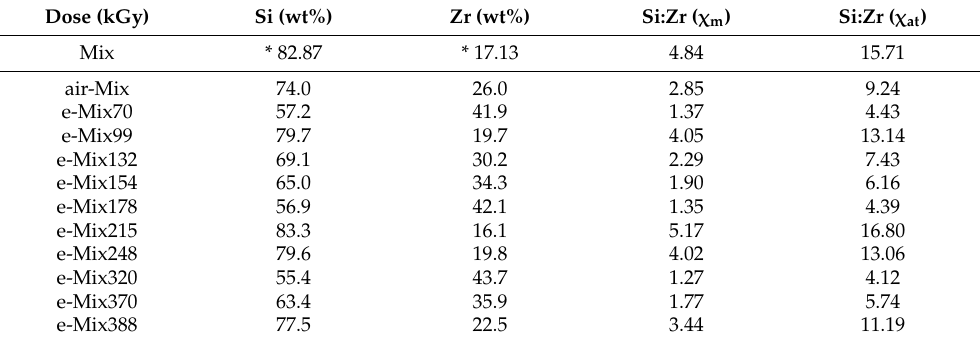
Table 3. Si and Zr content (Despite IUPAC recommendations ([35], p 97), WDXRF results are presented in percentage of weight (wt%) as this is the unit indicated by the equipment’s software.) in (air/e-)Mix samples, normalised to 100% and Si:Zr mass and atomic fraction ( χ m and χ at ).